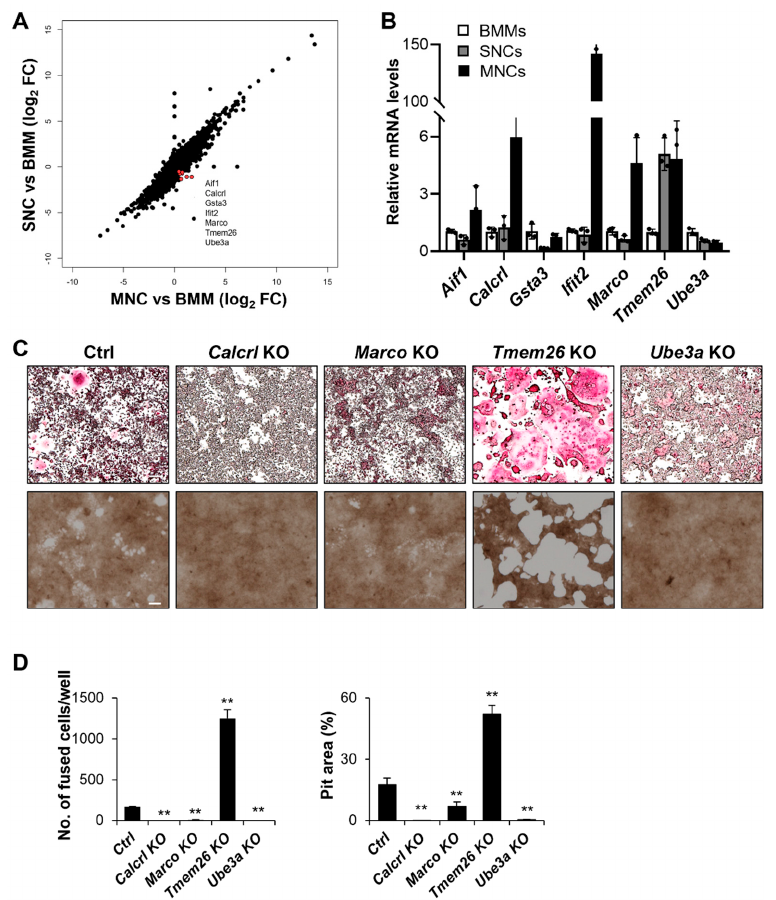
Figure 6. Seven potential targets regulate SNCs and MNCs. ( A ) In the SNC-BMM and MNC-BMM comparisons, only seven genes showed an opposite direction (red dots). Other genes revealed the same expression patterns (black dots). ( B ) The mRNA expression levels of the seven genes were tested using qRT-PCR. ( C ) TRAP staining (up) and bone resorption (down) assays were performed to examine Calcrl- , Marco- , Tmem26- , or Ube3a -knockout (KO) RAW 264.7 cells. Cells were cultured in RANKL-containing medium to differentiate them into osteoclasts. Ctrl, control RAW 264.7 cells. Scale bar, 100 µ m. ( D ) The fused osteoclasts with more than three nuclei in ( C ) were counted after TRAP staining ( right graph). The fit area in ( C ) was measured using the ImageJ software ( left ) (**, p < 0.01 compared to